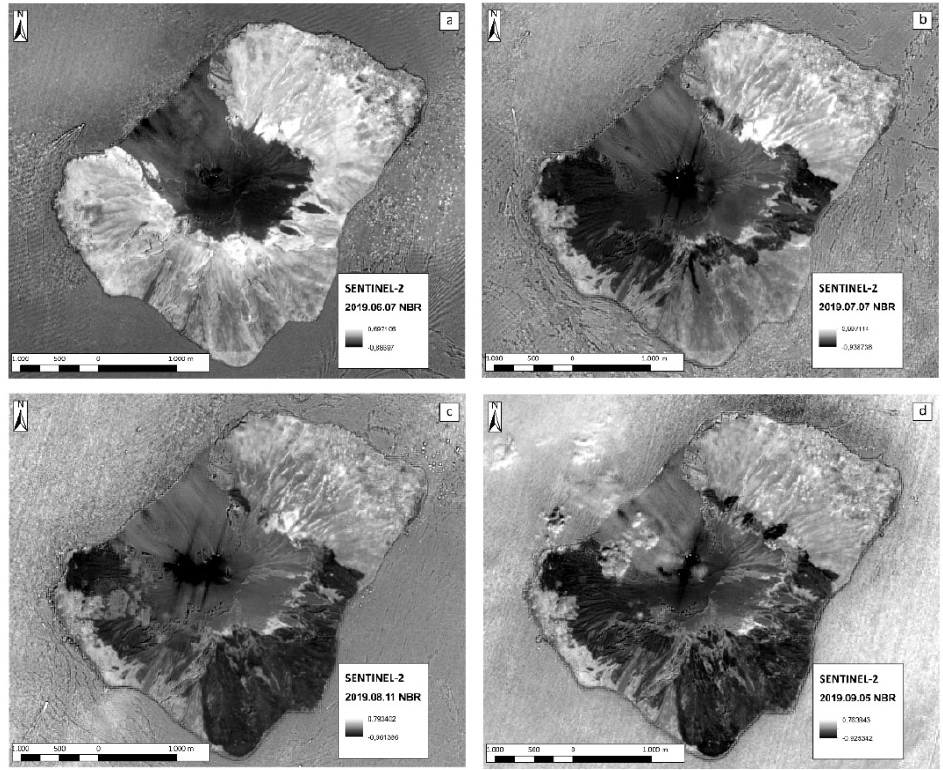
Figure 4. Sentinel ‐ 2 images ‐ derived NBR on: ( a ) 7 th June 2019 (pre ‐ eruption), ( b ) 7 th July 2019, ( c ) 11 th August 2019, ( d ) 5 September 2019. Thermal (black) anomalies in the summit area and Sciara del Fuoco August 2019, ( d ) 5 th September 2019. Thermal (black) anomalies in the summit area and Sciara del in ( b ), and ( c ), are related to the e ff usive Fuoco in ( b ), and ( c ), are related to the effusive activity.